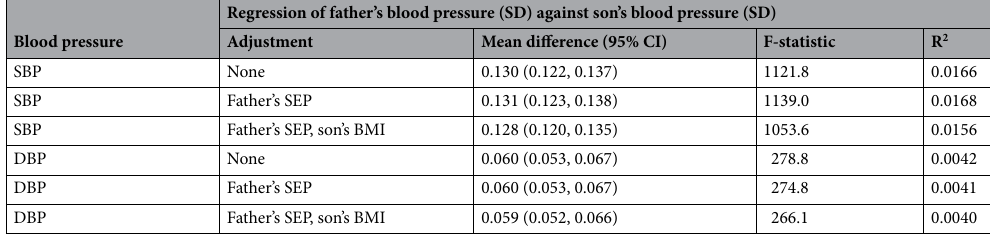
Table 1. Mean differences in father’s blood pressure per standard deviation (SD) of son’s blood pressure. Systolic blood pressure (SBP) and diastolic blood pressure (DBP) were each pre-adjusted for regional patterns, secular trends and age at examination. Blood pressure in fathers and sons was analysed in SD units (10.80 mmHg SBP and 9.22 mmHg DBP). Mean differences were obtained from linear regression and provide the denominators for the ratio method instrumental variable estimates. N = 66,567. Partial F-statistics and R 2 are provided as measures of instrument strength.